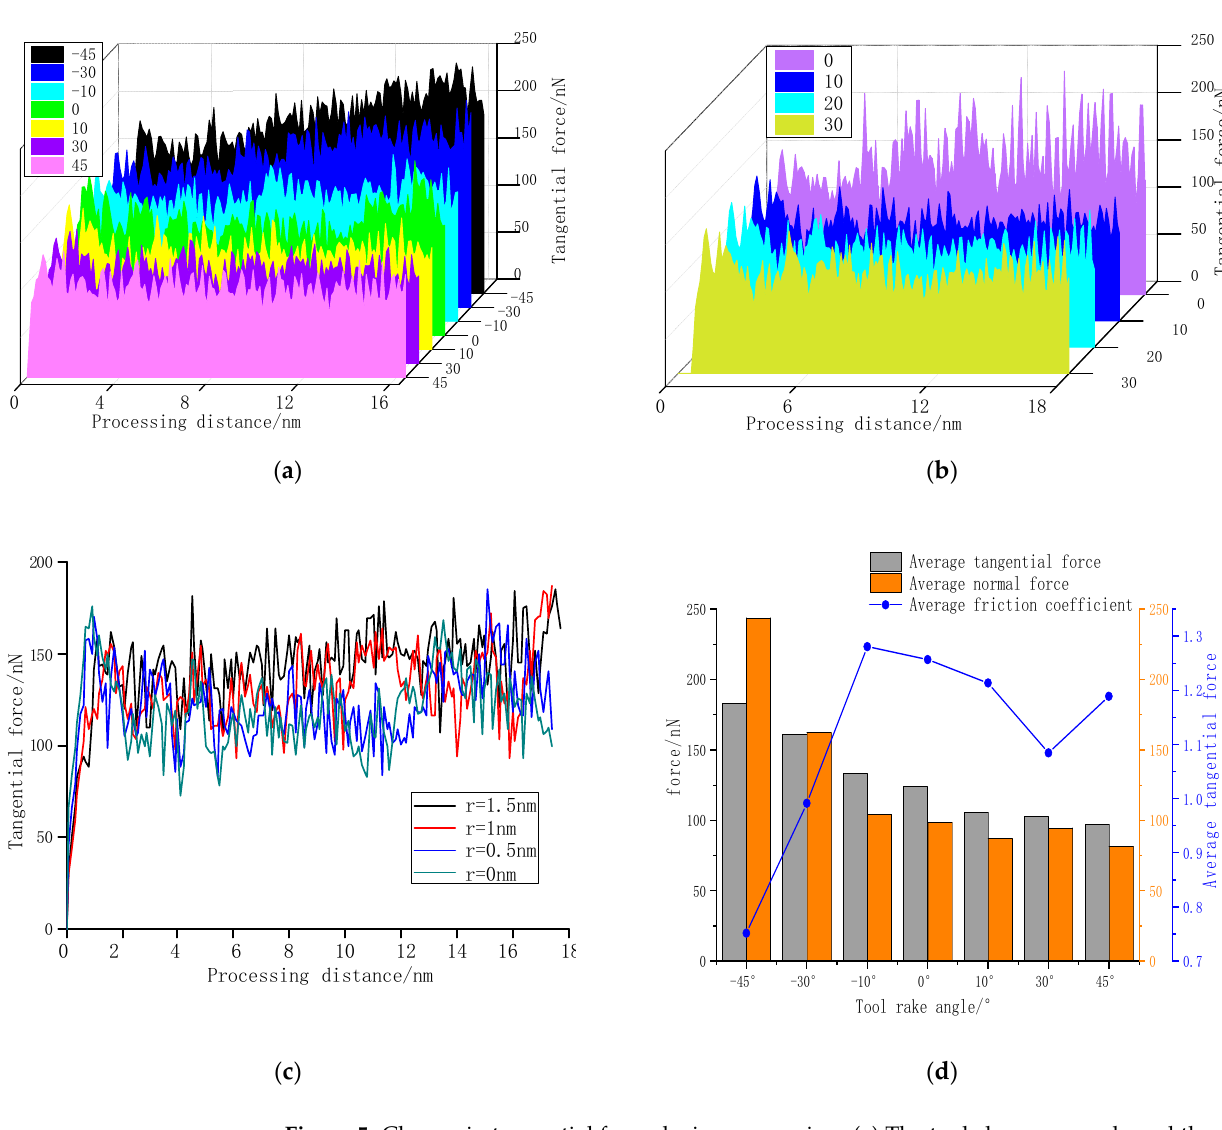
Figure 5. Change in tangential force during processing. ( a ) The tool clearance angle and the edge radius are the same, when the tool rake angle is different. ( b ) The tool rake angle and the edge radius are the same, and the tool clearance angle is different. ( c ) The front and clearance angles of the tool are the same, and the edge radius are different. ( d ) The relationship between friction coefficient and rake angle.